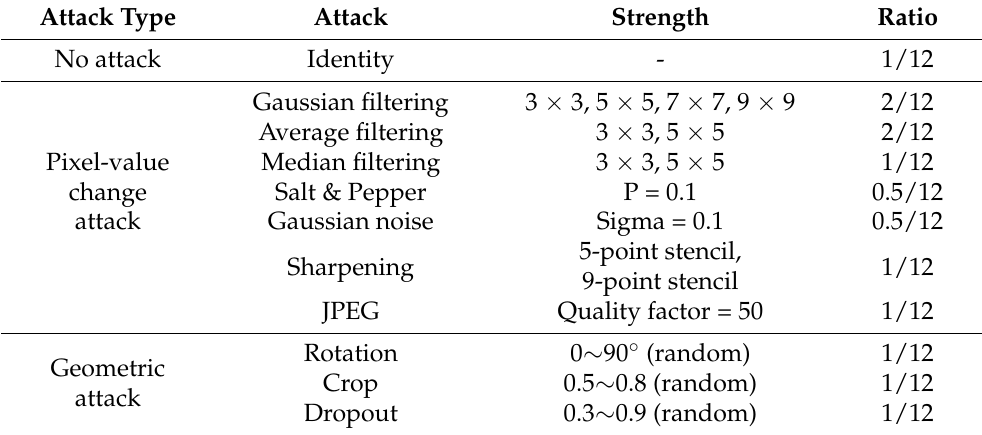
Table 1. Attacks used in training.